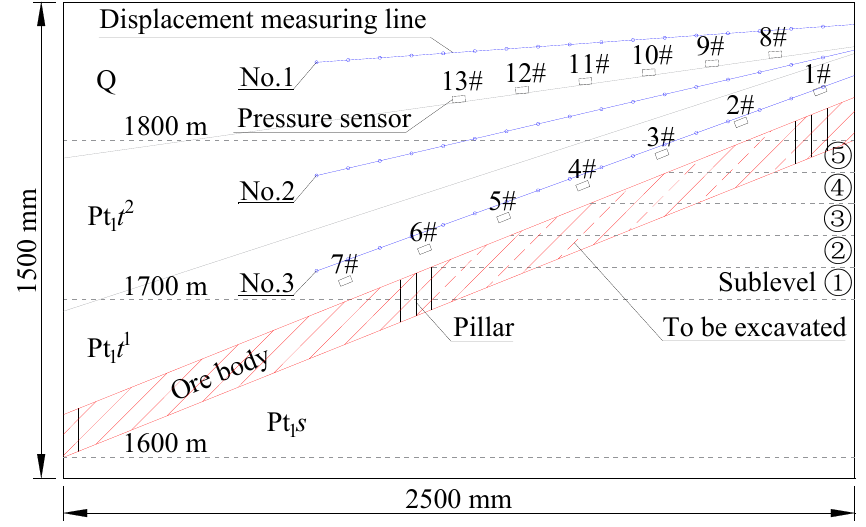
Figure 1. Layout of the physical model.